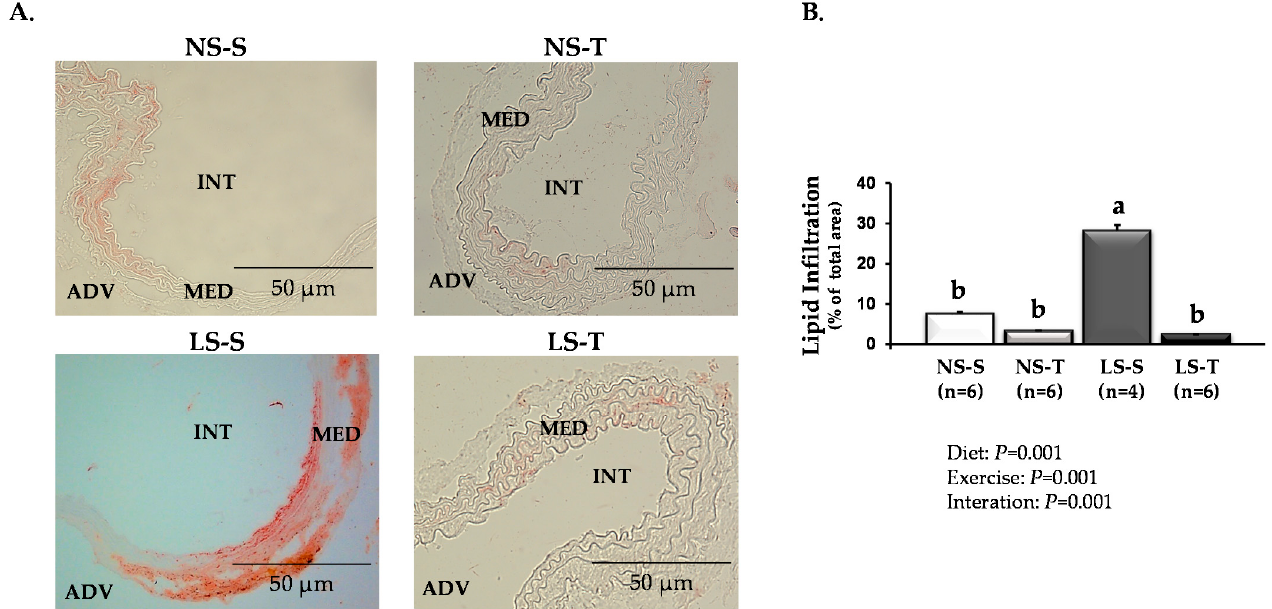
Figure 2. Vascular lipid infiltration in LDLR KO mice fed either a normal-sodium (NS) or a low- sodium (LS) diet, trained (T) or sedentary (S), after 90 days. ( A ) Representative micrographs of the brachiocephalic trunk stained with Oil Red O. The red staining indicates lipid infiltration. ADV, adventitia; MED, media; INT, intima (400×). ( B ) Histomorphometric analysis of Oil Red O-stained lipid infiltration in the brachiocephalic trunk. Two-way ANOVA test with two fixed factors (diet and exercise) and Tukey’s post-test were applied for comparisons among data. Results are expressed as mean ± standard deviation. Diet: p = 0.001; exercise: p = 0.001; interaction: p = 0.001. Distinct letters represent differences among groups ( p < 0.05). n = number of mice.